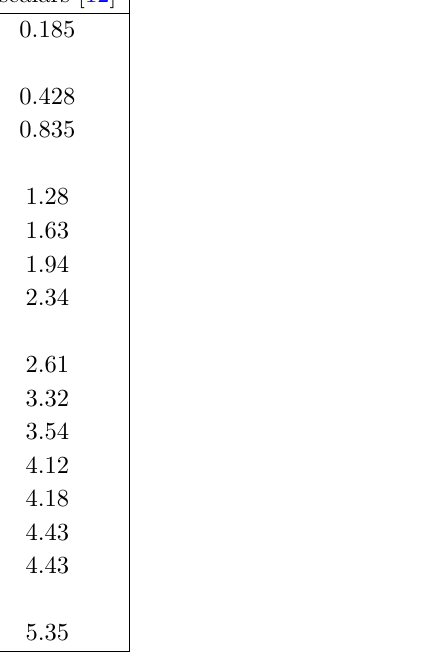
Table 1 . The scalar spectrum m 2 of the KS solution as calculated by us with the eight-scalar sigma-model, compared to the seven-scalar sigma-model adopted in [12]. We normalize the values of m 2 so that they can be compared. The empty spaces correspond to states that are missing in the case of seven